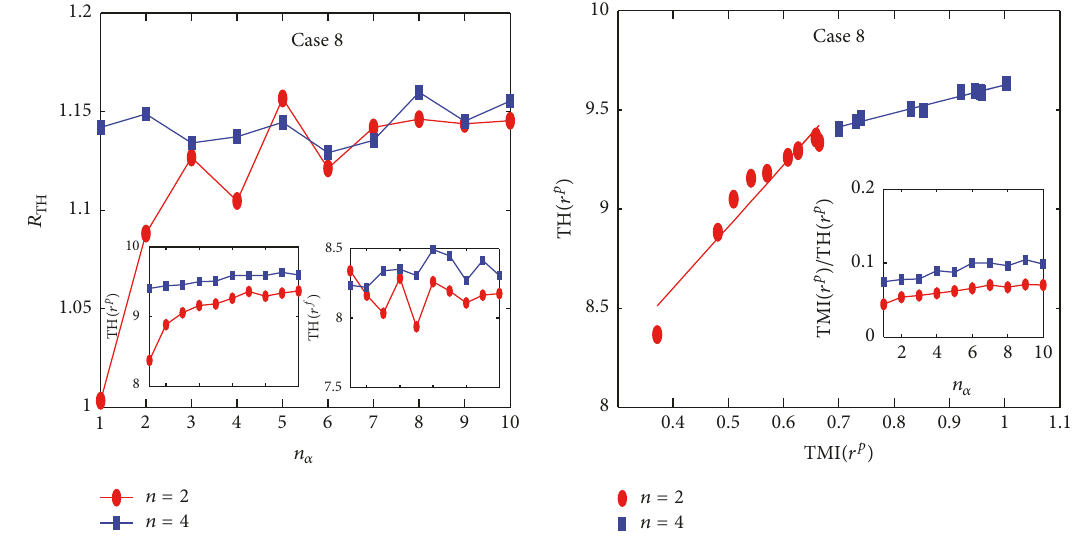
Figure 8: Results of robustness check of the